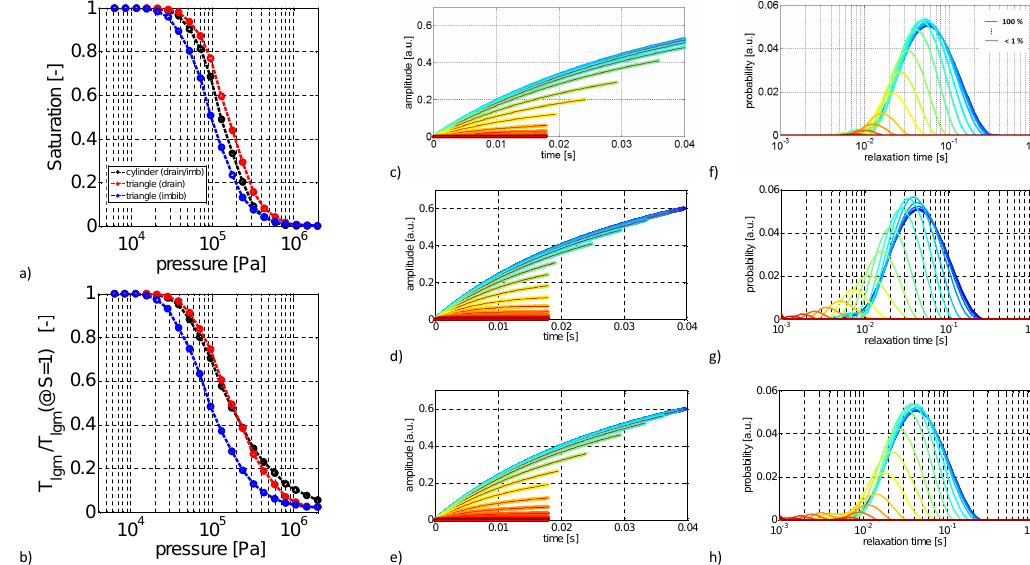
Figure 15. (a) Modeled drainage and imbibition curves for circular and equilateral triangular capillary ensemble (cf. Fig. 14) and (b) Cor- responding normalized mean NMR T 1 relaxation times versus pressure curves. Modeled and fitted (red lines) NMR transient signals (longi- tudinal magnetization evolution) and corresponding inverted NMR T 1 relaxation-time distributions for 20 fully and partially saturated pore size distributions ranging from < 1 to 100% saturation using circular (c, f) and equilateral triangular capillaries during imbibition (d, g) and drainage (e, h)